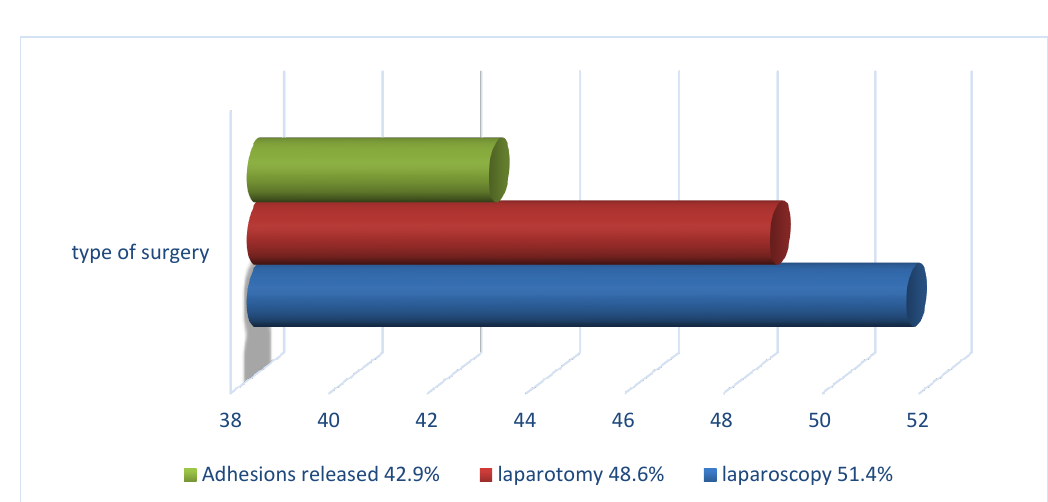
Fig. 1. Surgical details of re-operations–a type of surgery, presence of adhesions.